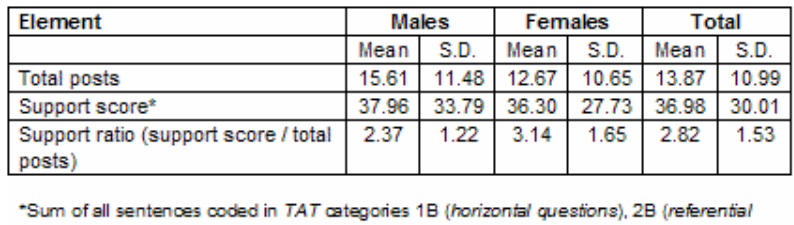
Table 1. Conference participation, support score, and support ratio, by